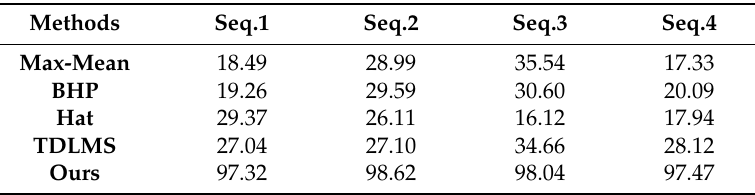
Figure 12. Cumulative results of inter-frame detection.